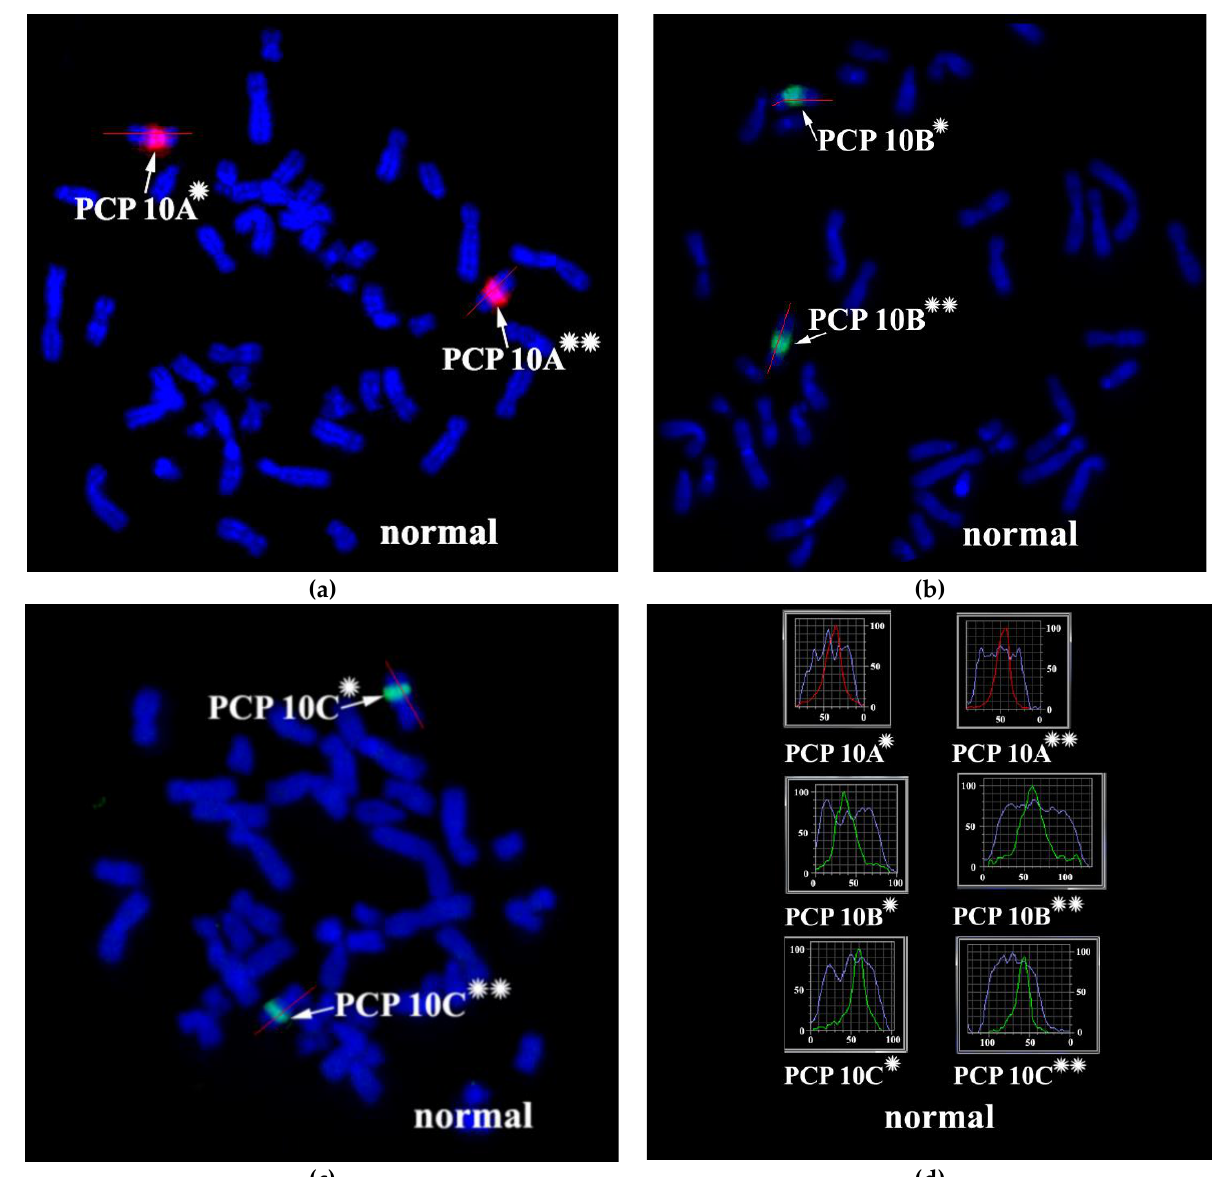
Figure 2. CISS hybridization of microdissected partial chromosome paints (PCPs; specific for three regions of human chromosome 10) with metaphase chromosomes of a healthy individual. ( a ) PCP10A (red signal), ( b ) PCP10B (green signal), and ( c ) PCP10C (green signal). ( d ) Fluorochrome profiles of homologous chromosome 10. The red line along the body of the chromosome is the line along which the profile of the relative signal intensity was determined. DAPI-stained chromosomes are blue. → indicates signals produced by the probe set on chromosome 10. * and ** mark the two homologous chromosomes